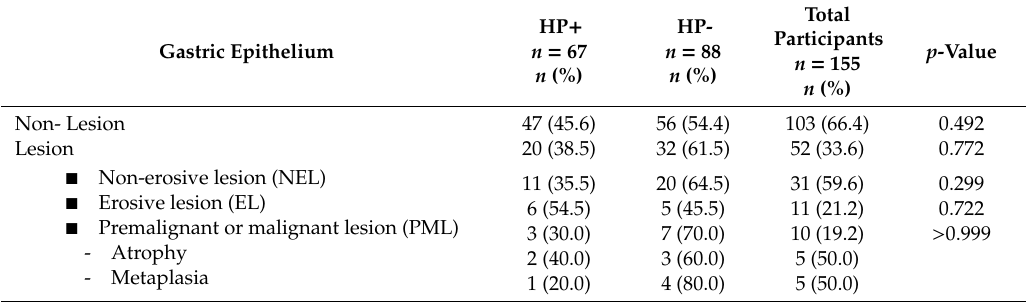
Figure 1. H. pylori infection dynamics according to age range. Distribution of patients colonized and not colonized by H. pylori according to age and expressed in years. Table 2. Gastric epithelium state according to injury level and Helicobacter pylori colonization.